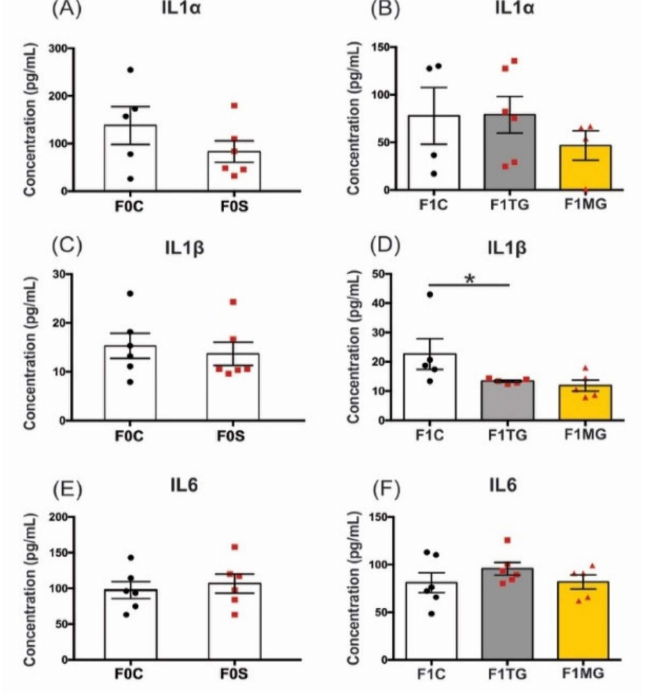
Figure 10. Decreased uterine IL-1 β protein concentrations in F1 generation of SIS-exposed dams. ( A , B ) The levels of IL1 α protein were unaltered in F0 and F1 uteri, although they showed a tendency to decrease in the F1 dams of the MG lineage. ( C ) The IL-1 β protein levels in F0 uteri were unchanged, ( D ) but they significantly decreased in the TG lineage compared to F1 controls. In the MG lineage, IL-1 β protein also showed a tendency to decrease its levels but did not reach statistical significance. ( E , F ) Concentrations of IL-6 were unchanged in both generations and treatment groups. Data are presented as concentration (pg/mL), mean ± SEM. The F0 tissue homogenates were analyzed by independent t -test, whereas F1s were analyzed by ordinary one-way ANOVA with Tukey post-hoc test. Statistical significance: * p < 0.05, n =